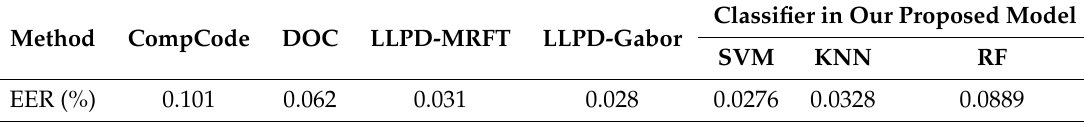
Table 5. Comparison with state-of-the-art methods in terms of EER value for the IITD touchless database. LLPD-MRFT: local line directional patterns-modified finite radon